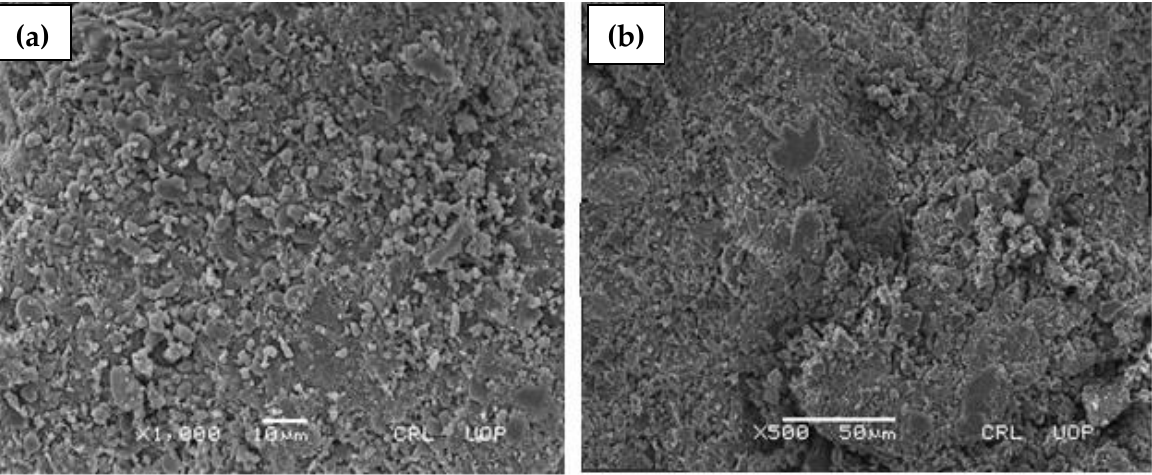
Figure 5. SEM (scanning electron microscopy) micrographs ( a ) βCD -CMC-g-poly (AMPS), ( b ) βCD -g-poly (AMPS) nanosponges. Table 1. Average particle size of the developed